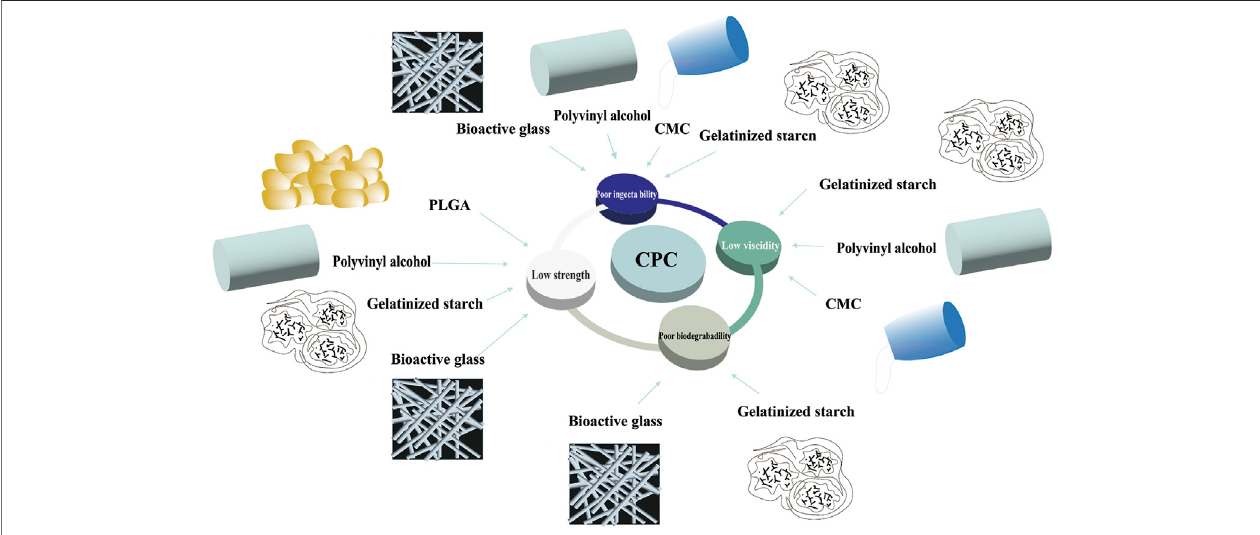
FIGURE 3 | Disadvantages of CPC and its modi fi cations. CPC, calcium phosphate cement; CMC, carboxymethyl cellulose; PLGA, poly (l-lactide-co- glycolide)